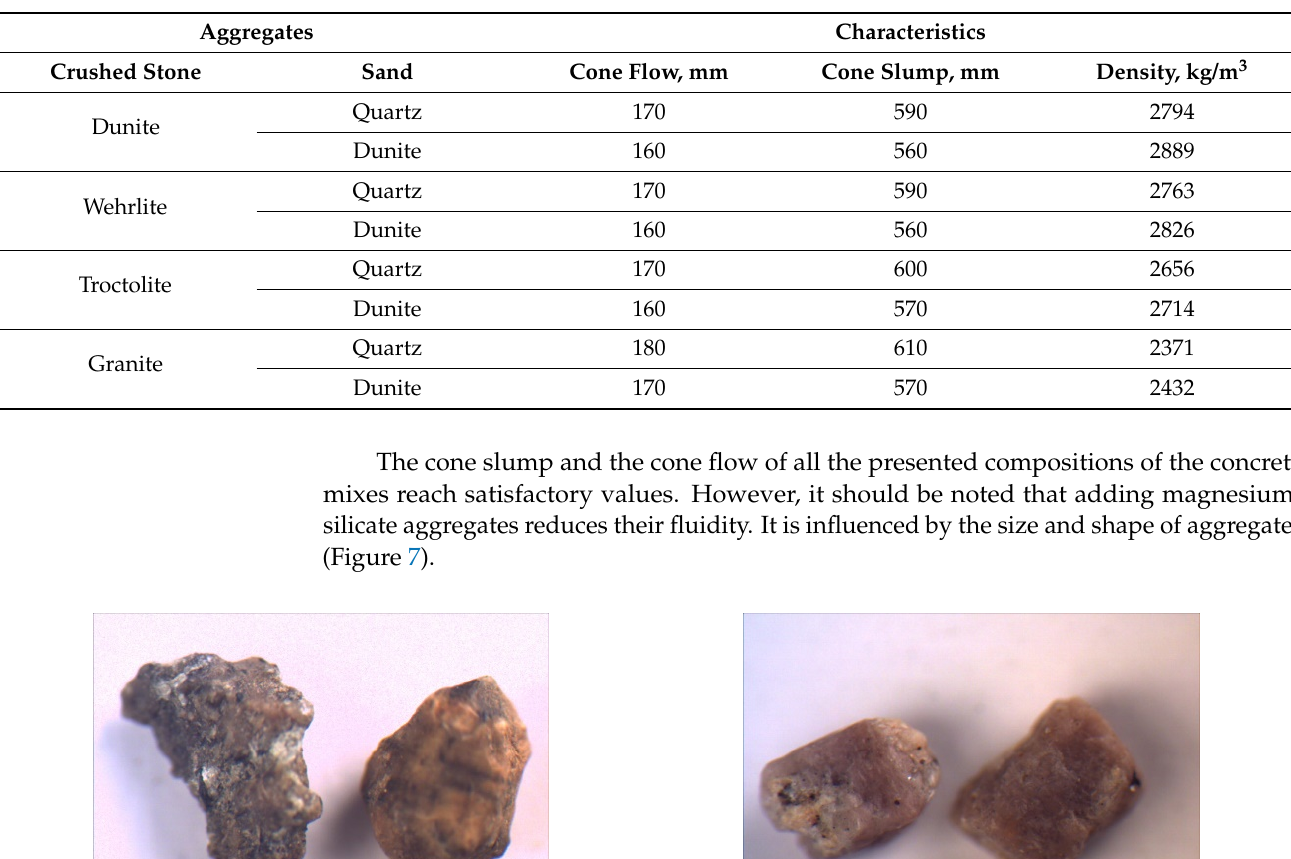
Table 4. Characteristics of concrete mixes.